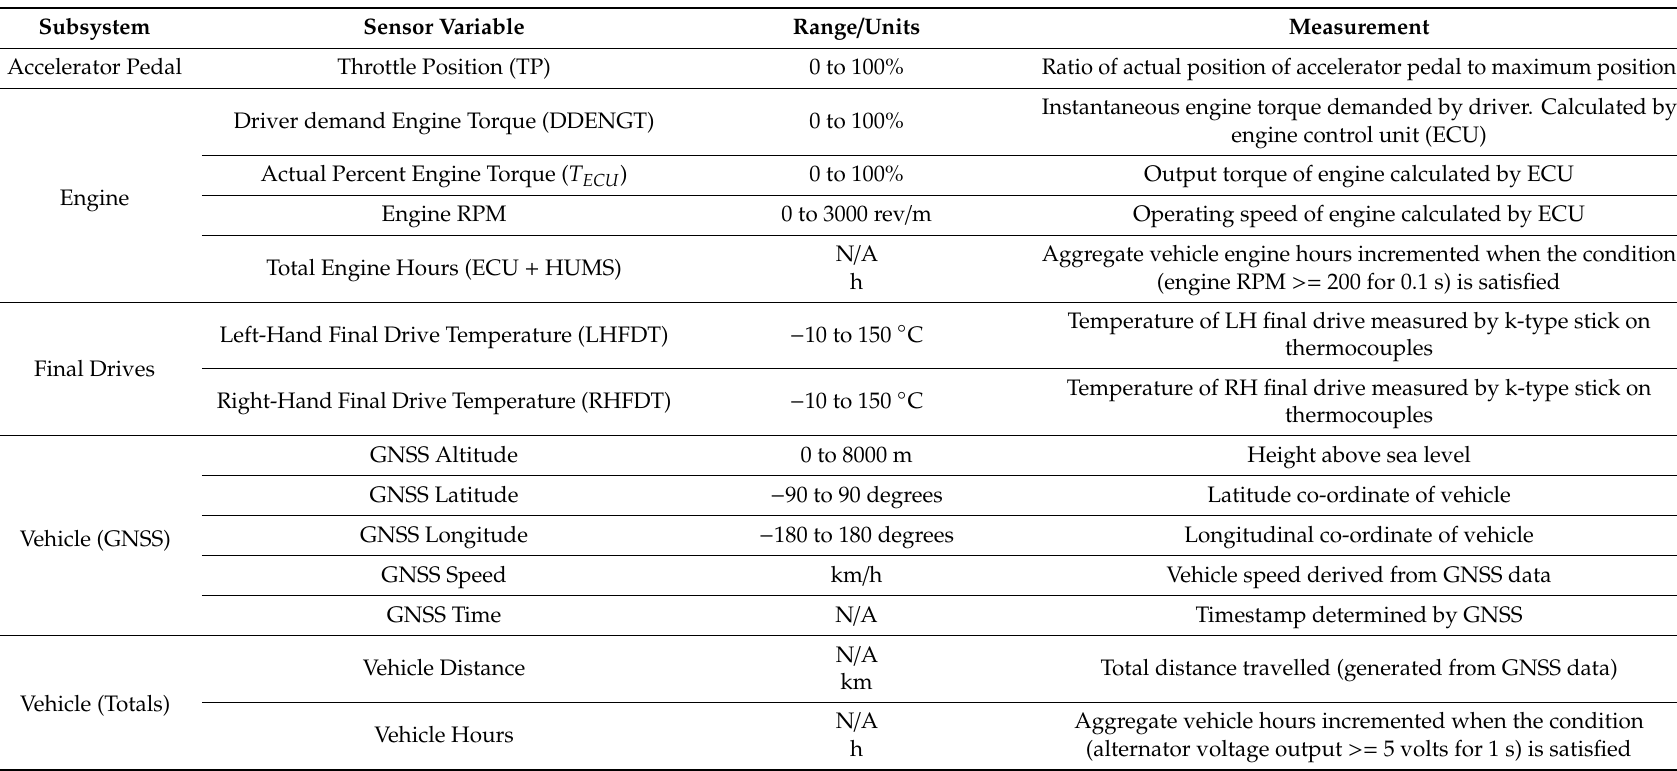
Table 2. List of sensor